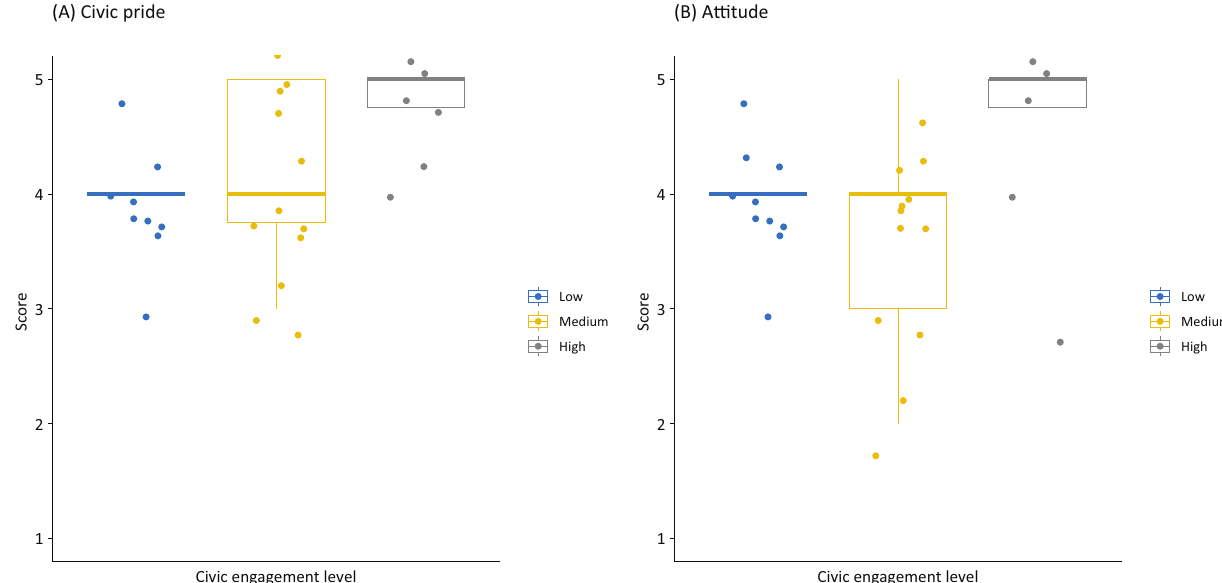
Figure 3. Scores of (a) elevation of civic pride through the living lab participation and (b) participants’ attitude toward applying living lab to smart city development by civic engagement levels (low, medium, and